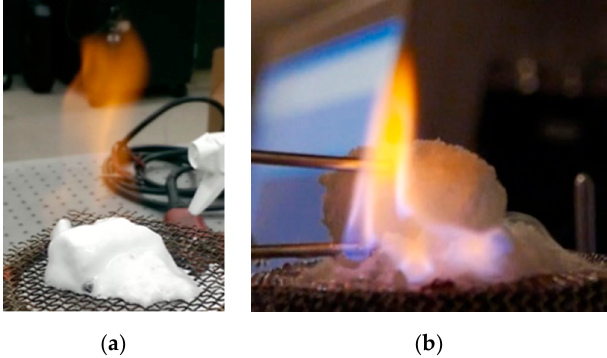
Figure 6. Gas hydrate burning ( a ) with surfactant sodium dodecyl sulfate (SDS) and ( b ) with no surfactant.